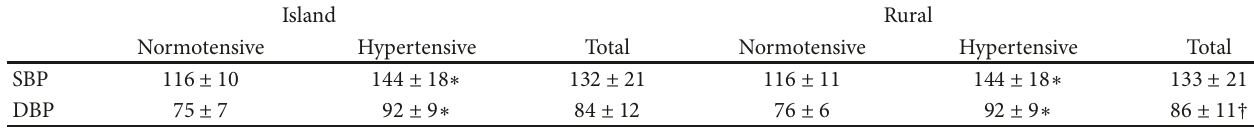
Table 2: The systolic and diastolic blood pressures in island and rural residents (mmHg). Island Rural Normotensive Hypertensive Total Normotensive Hypertensive Total